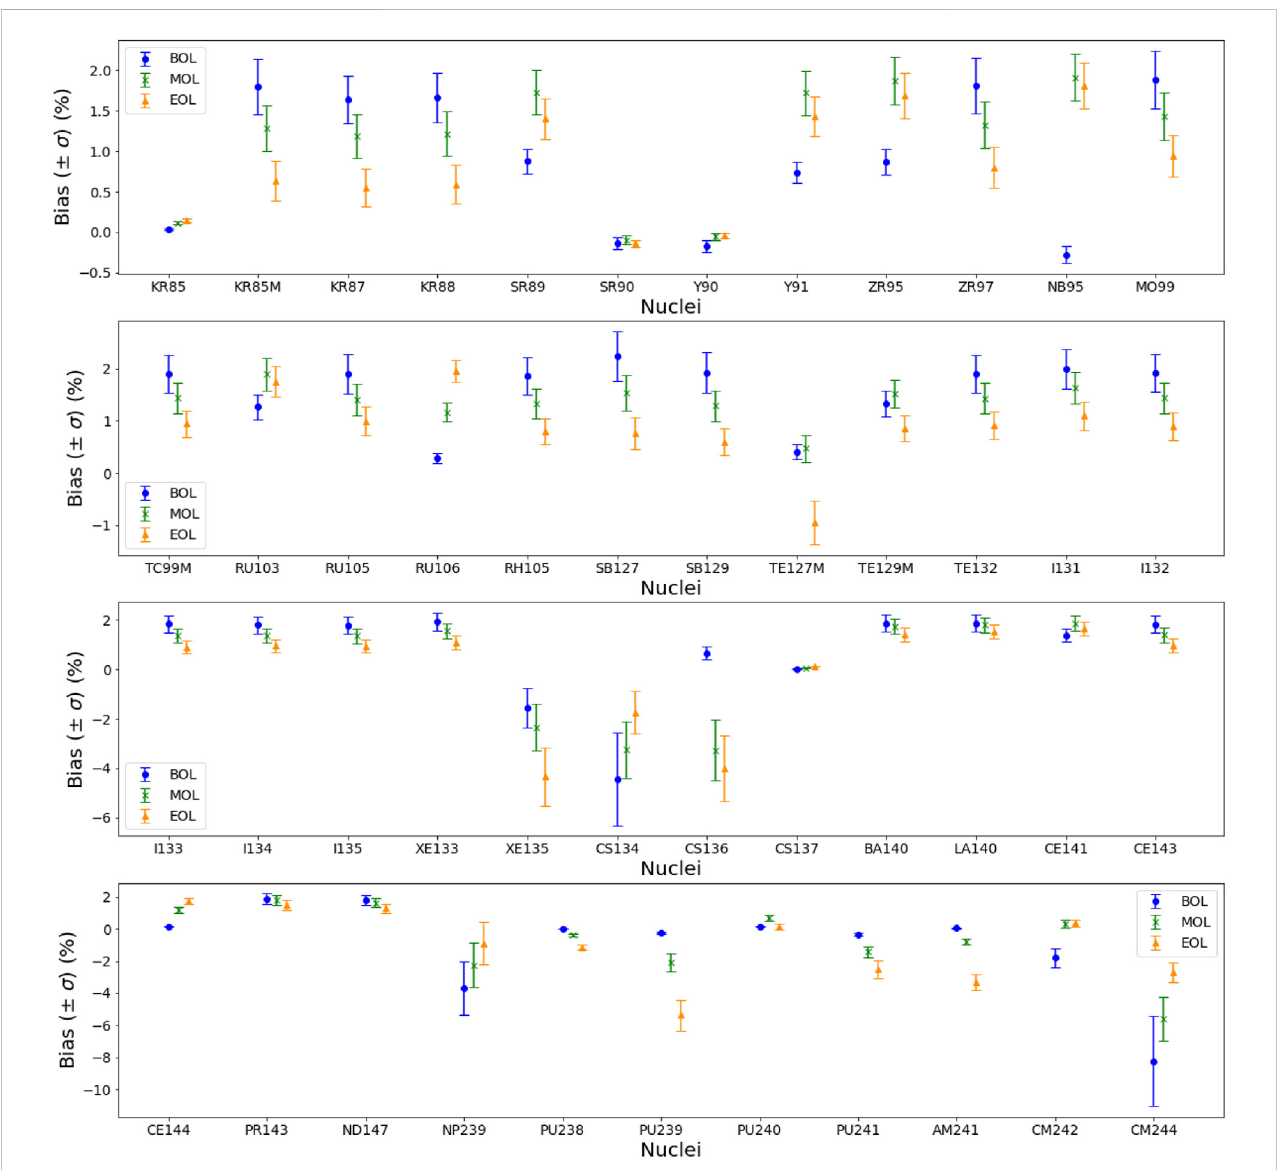
Average bias and its uncertainty (1 σ ) due to ILA on the assembly nuclide inventory, for three burnup values, for MOX